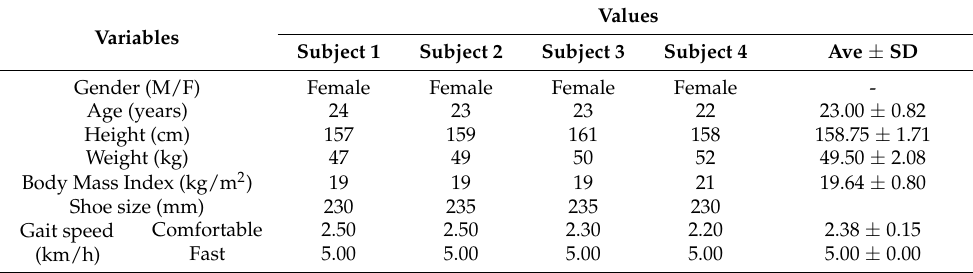
Table 2. Anthropometric and general characteristics of the subjects.